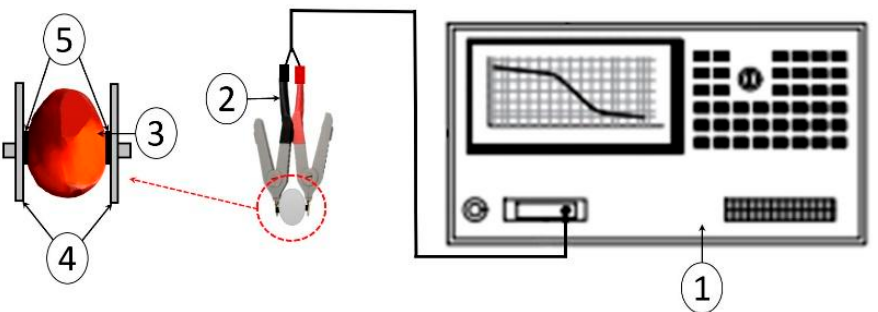
Figure 9. Schematic diagram of electrical impedance measurement of oil palm fruitlets; (1): LCR meter, (2): Kelvin clip leads, (3): oil palm fruitlet sample, (4): sticky plastic foam, (5): ECG electrode.